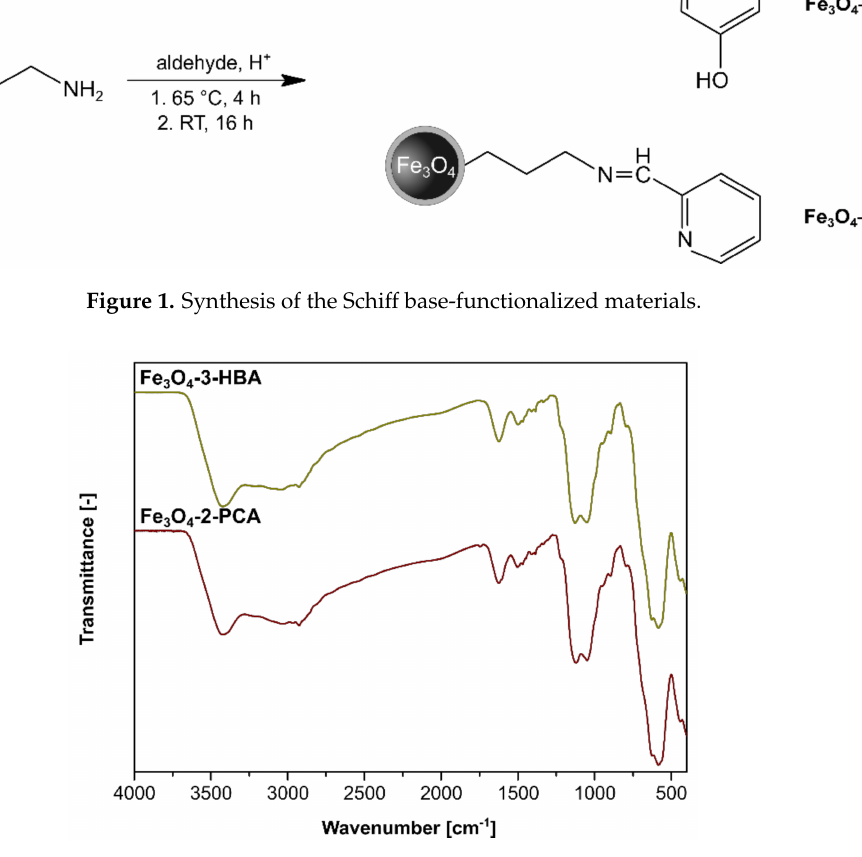
Figure 2. The FT-IR spectra of the synthesized